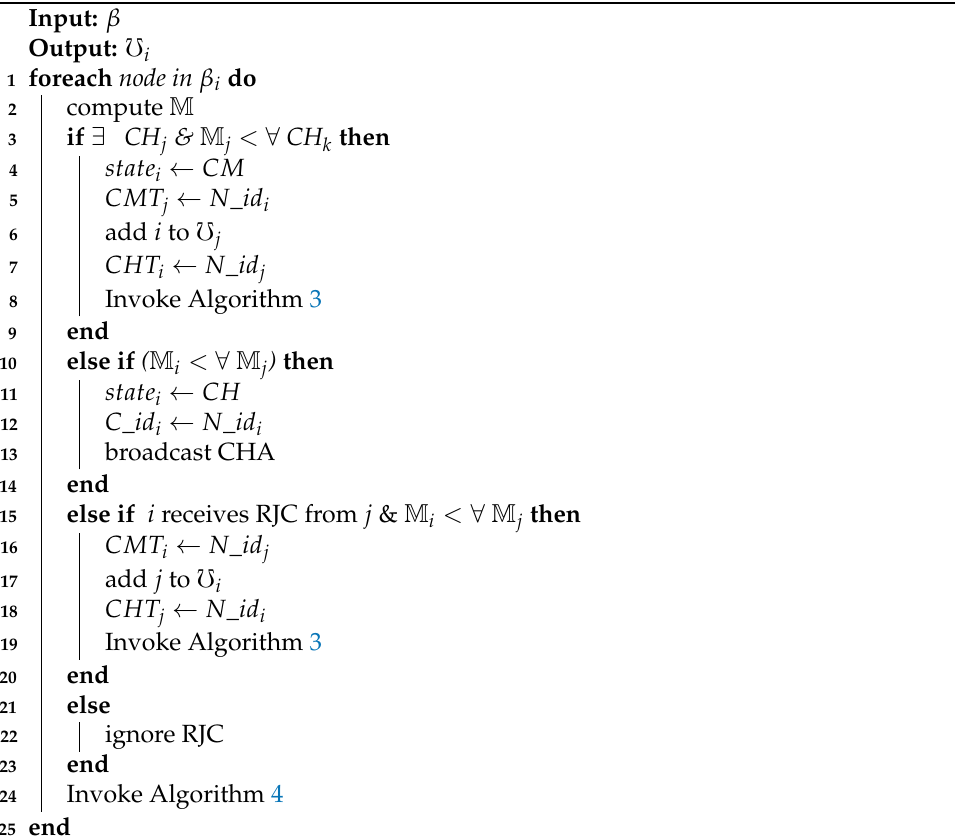
Algorithm 2: Cluster